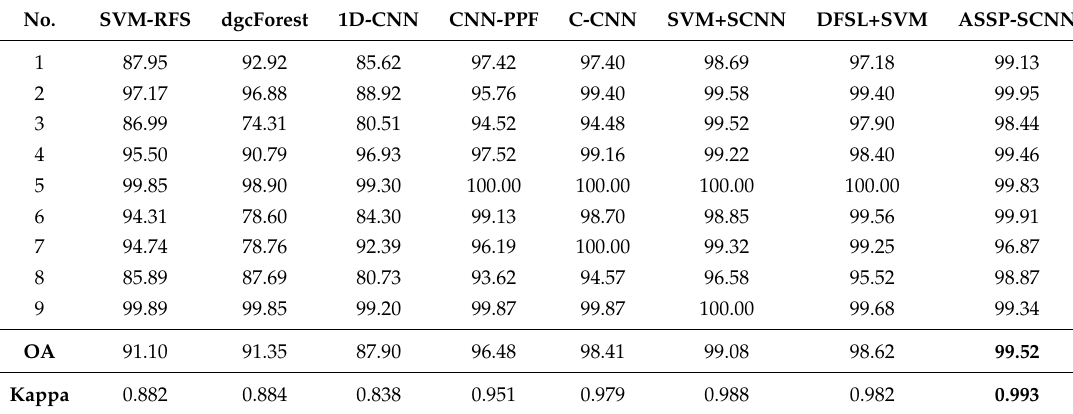
Table 9. Class-specific accuracy (%), OA (%) and Kappa coefficient of ASSP-SCNN and the comparing methods on PaviaU dataset with nine